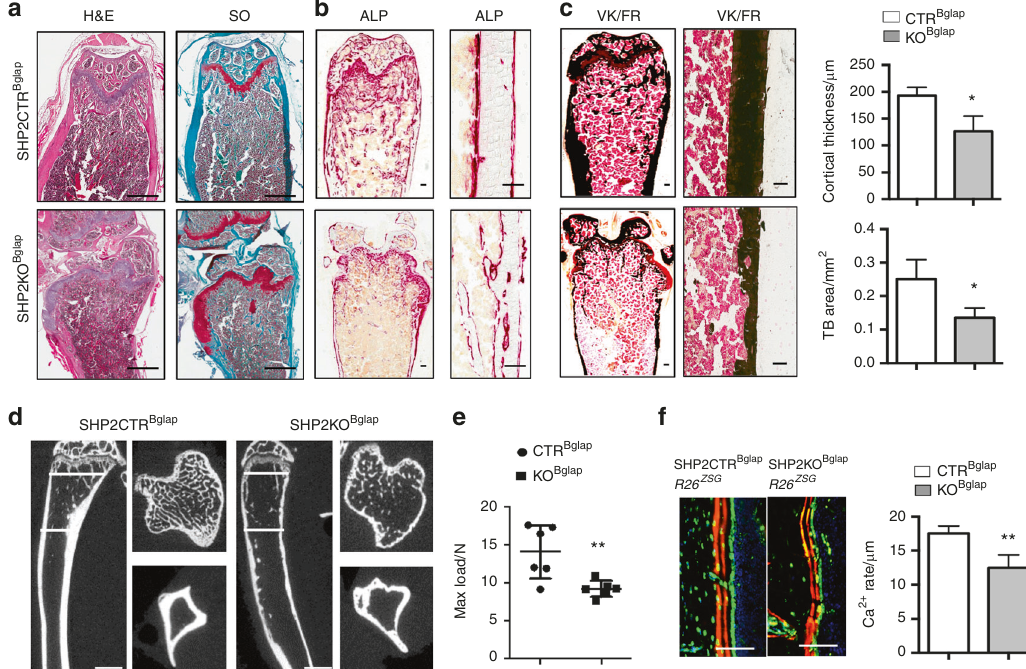
Fig. 2 SHP2 deletion in Bglap + cells leads to deformation of articular and growth plate cartilage, defective mineralization of cortical and cancellous bone, and bone volume reduction. a Distal femur paraf fi n sections stained with H&E and Safranin O (SO) demonstrate the structure and histology of articular and growth plate cartilage in 13-week-old mice with the indicated genotypes. Scale bar: 1 mm. Femoral frozen sections stained for ALP activity ( b ) and mineral deposition with the von Kossa (VK) method ( c ) of the mice described in a . The low-power full images are shown in Fig. S2c. Quanti fi ed cortical bone thickness and mineralized cancellous bone areas are presented as bar graphs on the right ( n = 4, * P < 0.05, Student ’ s t -test). Scale bar: 100 μ m. d Representative sagittal and transverse µCT radiographs show the microarchitecture of the proximal tibia from 10-week-old male mice with the indicated genotypes. The sectioning planes are marked by lines. Scale bar: 1 mm. e Scatter plots show the maximum load of the tibia from 10-week-old male mice determined using the 3-D bending test ( n = 6, ** P < 0.01, Student ’ s t -test). f Fluorescent images of femoral frozen sections showing new bone formation in 13-week-old mice that received xylenol orange injection at days 7 and 2 prior to euthanasia. Quanti fi ed data are shown by bar graphs on the right ( n = 4, ** P < 0.01, Student ’ s t